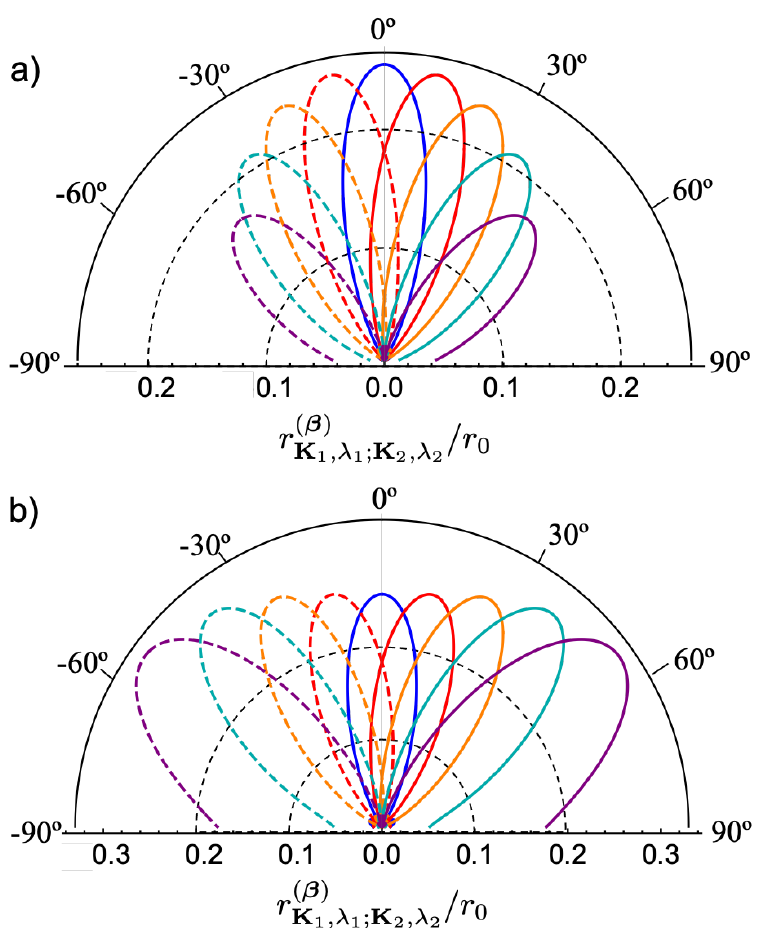
Figure 2. Two-photon angular emission. Emission lobes in the xz -plane of one of the DCE emitted photons with ( a ) TE and ( b ) TM polarization for various magnitudes of the momentum kick β = β ˆ x , namely, c β / Ω = 0 (blue), ± 0.1 (red), ± 0.2 (orange), ± 0.3 (cyan), and ± 0.4 (purple). Solid (dashed) curves correspond to positive (negative) values of β . The other photon is assumed to be emitted along the z -direction, and we trace over its polarization degree of freedom. The parameters are N x = N y = 50, N z = 1, L x = L y = 20 c / Ω , and ω 1 = ω 2 = Ω /2. The emission rate is normalized to Ω 3 ∆ 2 /16 ( 2 π ) 3 c 2 r 0 = N 2 x N 2 y N 2 z α 2 0